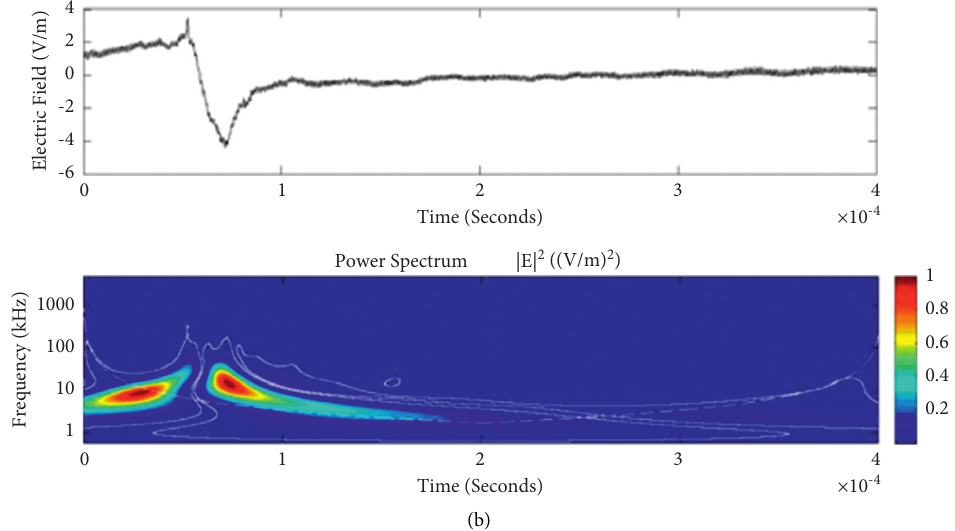
Figure 10: Example of the wavelet power spectrum of the first event (a) and second event (b) of the unusual lightning signal which is recorded as a flash number 20150416-0004 in Kathmandu, Nepal. The window size of the event is 400 μ